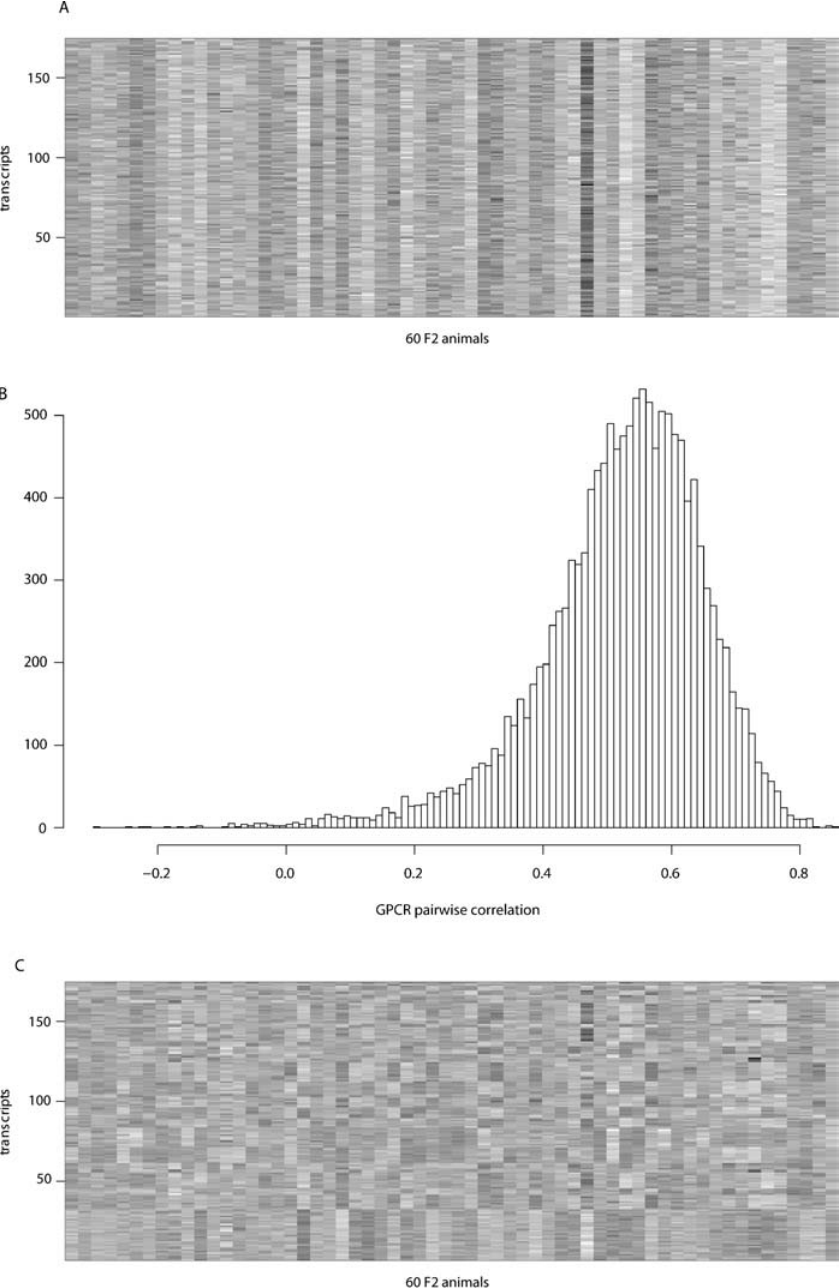
Figure 2. Coordinate Regulation of Genes for GPCR Protein Signaling Pathways (A) GPCR protein signaling pathway genes show coordinated changes across the 60 F 2 mice. The rescaled expression levels of 174 distinct transcripts (y- axis) that belong to the GPCR pathway. The x-axis displays the 60 F 2 mice. The plot shows that the subset of GPCR traits identified by our trait correlation-GO analysis has vertical patterns that indicate coordinate expression across the 60 F 2 mice ( P ¼ 1e10 (cid:2) 4 by permutation test). (B) Histogram of pairwise correlation coefficients of GPCR traits identified with different seeds. (C) Scaled expression levels of traits from one realization of the permuted lists. Thirty-eight lists of correlated traits were randomly sampled from a total of 1,341 correlated trait lists. The list sizes were adjusted to match those of the GPCR lists. The expression values were scaled to have mean intensity ¼ 0 and variance ¼ 1, as in the GPCR list in Figure 2A. DOI: 10.1371/journal.pgen.0020006.g002